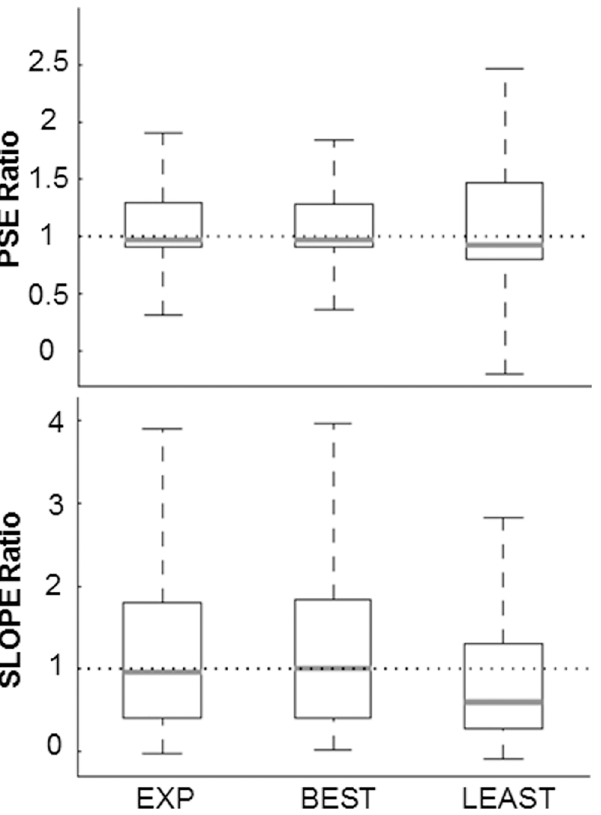
(same as in Fig 4) PSEs from muscle and psycho -metric measures calculated across bootstrap procedure. Lower graph depicts the ratio between the slopes of the two metrics curves for the three muscular